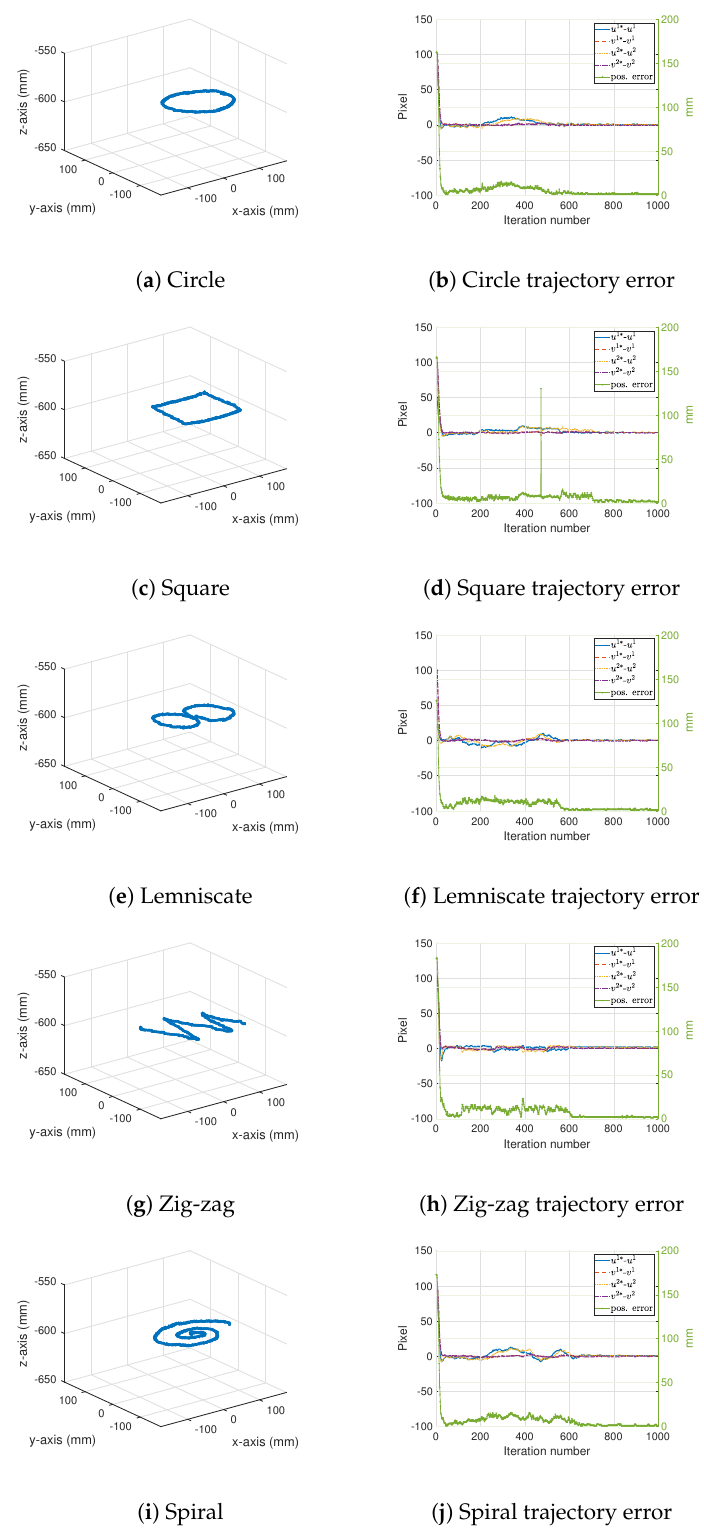
Figure 8. Measured target trajectories during freehand